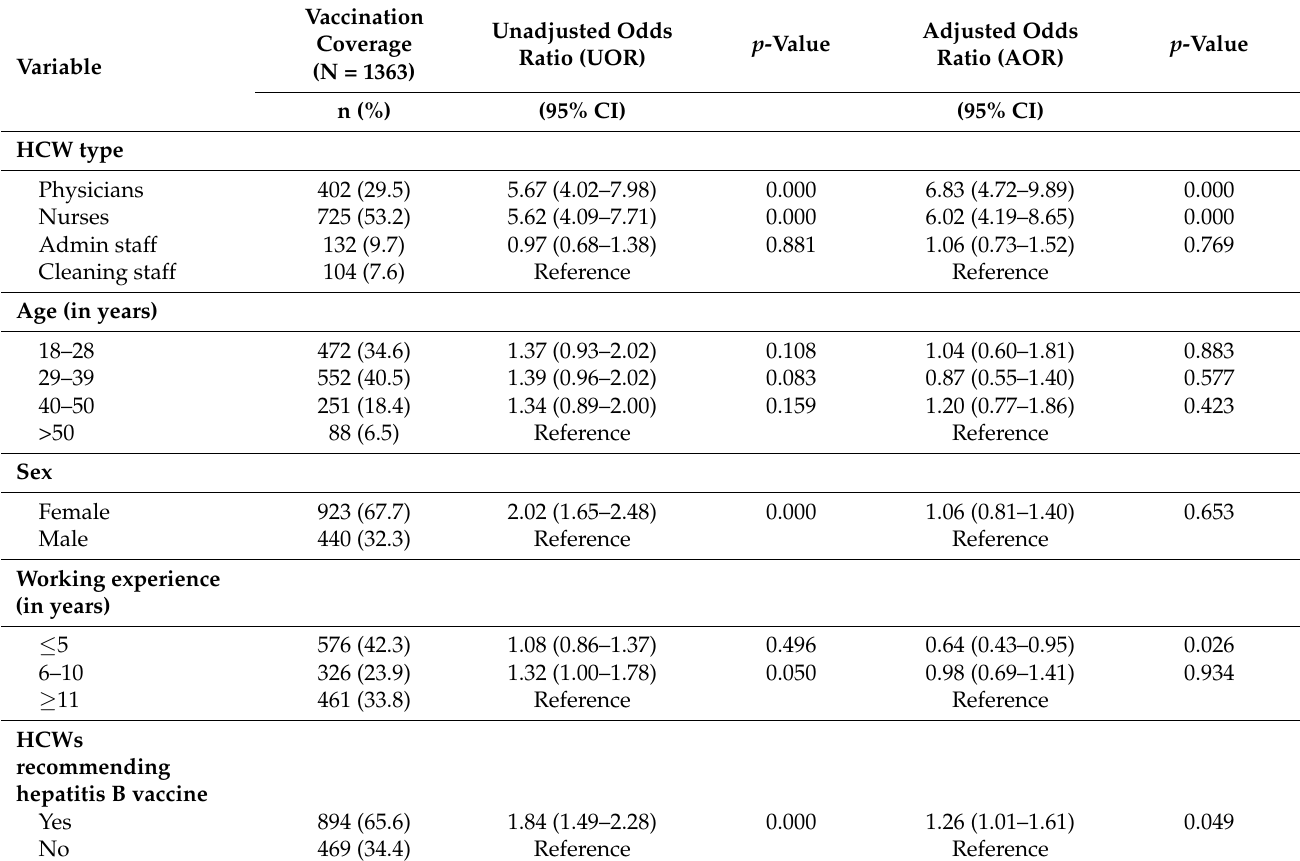
Table 3. Association between hepatitis B vaccination uptake and multiple predictors among vacci- nated